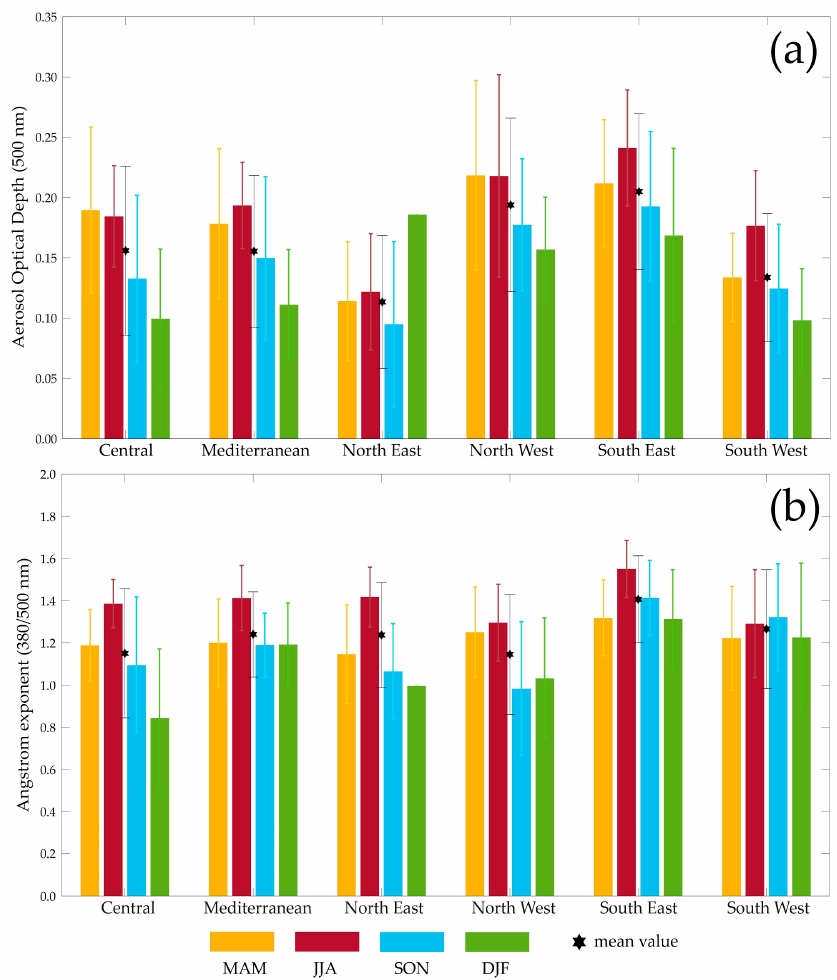
Figure 3. Optical properties of aerosols as retrieved from AERONET photometer measurements between 2008 and 2018: ( a ) aerosol optical depths (AODs) (500 nm) and ( b ) Angstrom exponents (AEs) (380/500 nm). The mean values and the standard deviations for the AODs and AEs for each cluster are indicated by a black marker and whiskers.